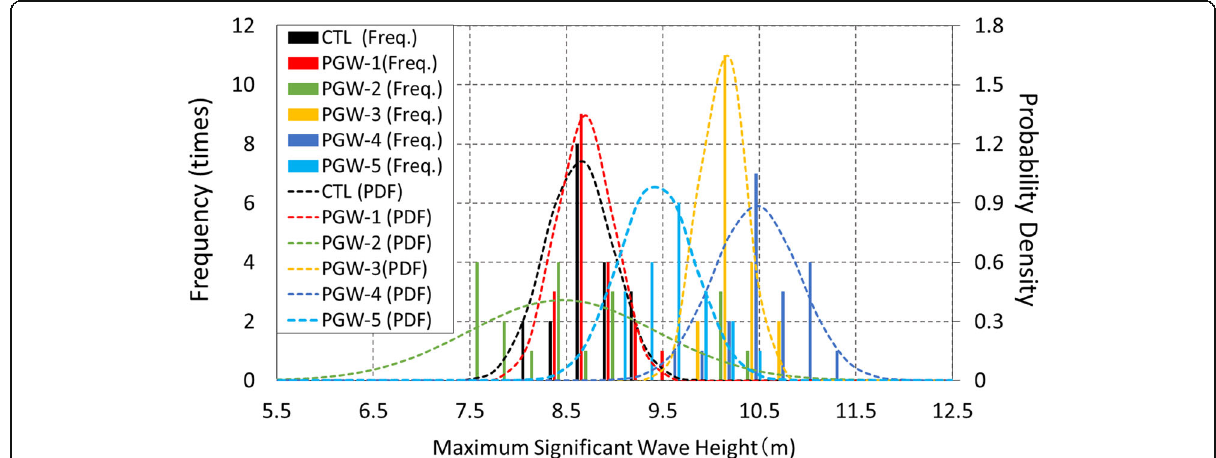
Fig. 14 Histograms ( “ Freq. ” ) and probability density function (PDF) curves of the maximum significant wave height. Results are for the offshore region of Suva in the CTL and five PGW simulations